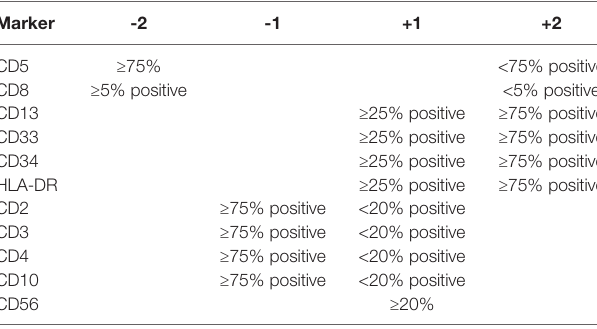
TABLE 3 | Scoring system based on 11-marker combination (12).